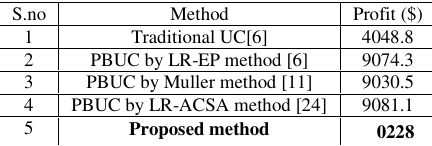
Table VII Comparison of the results of 3 unit system with existing